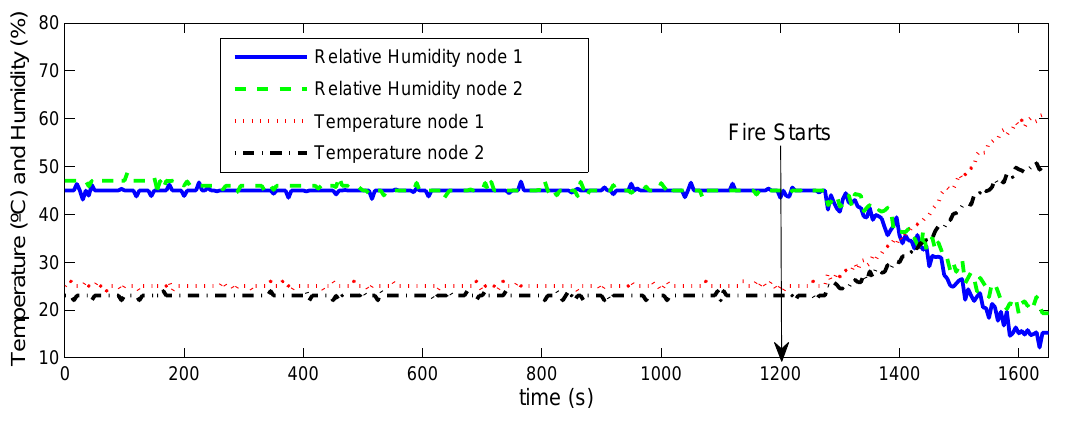
Figure 2. Temperature and relative humidity measurements obtained from two nodes at 3 m and 5 m from a fire